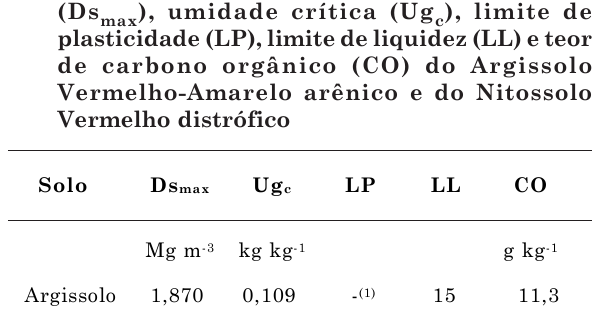
Figura 3. Limite de liquidez (LL), limite de plasticidade (LP) e umidade crítica para compactação (Ug ), considerando o teor de c carbono orgânico de um Nitossolo Vermelho distrófico (** modelo ajustado é significativo a (1) O Argissolo não apresentou plasticidade. p ≤≤ ≤≤ ≤ 0,01 pelo teste F).